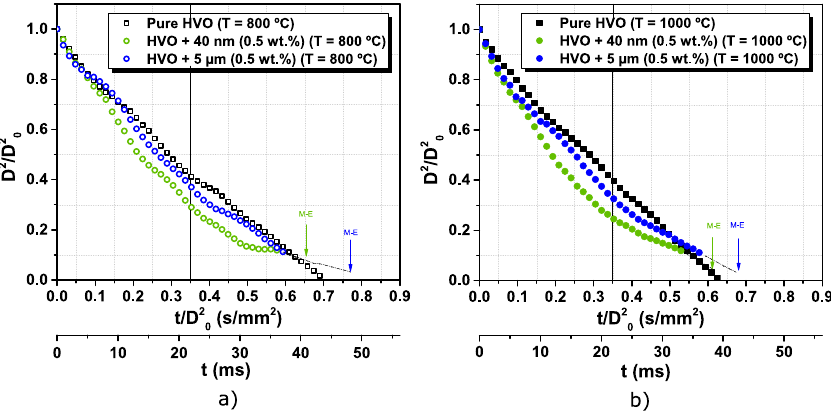
Figure 14. Square of the normalized droplet diameter as a function of the normalized time at ( a ) T = 800 ◦ C and ( b ) T = 1000 ◦